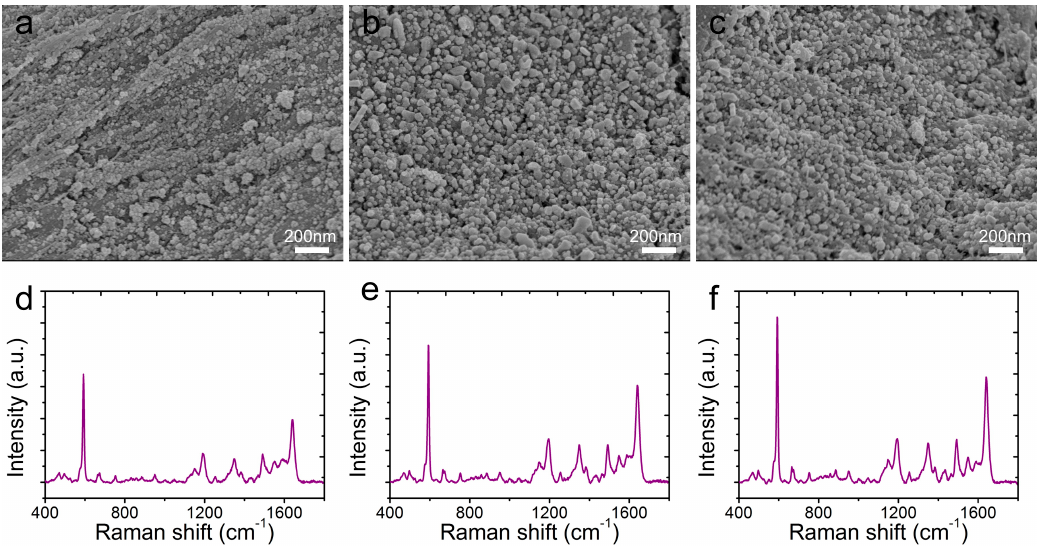
Figure 4. SEM images of the CS@PDA@AgNPs swabs after reacting with [Ag(NH 3 ) 2 ]+ anions for ( a ) 4 h, ( b ) 8 h and ( c ) 12 h. ( d – f ) The respective SERS spectra of NBA collected on the 4 h, 8 h and 12 h